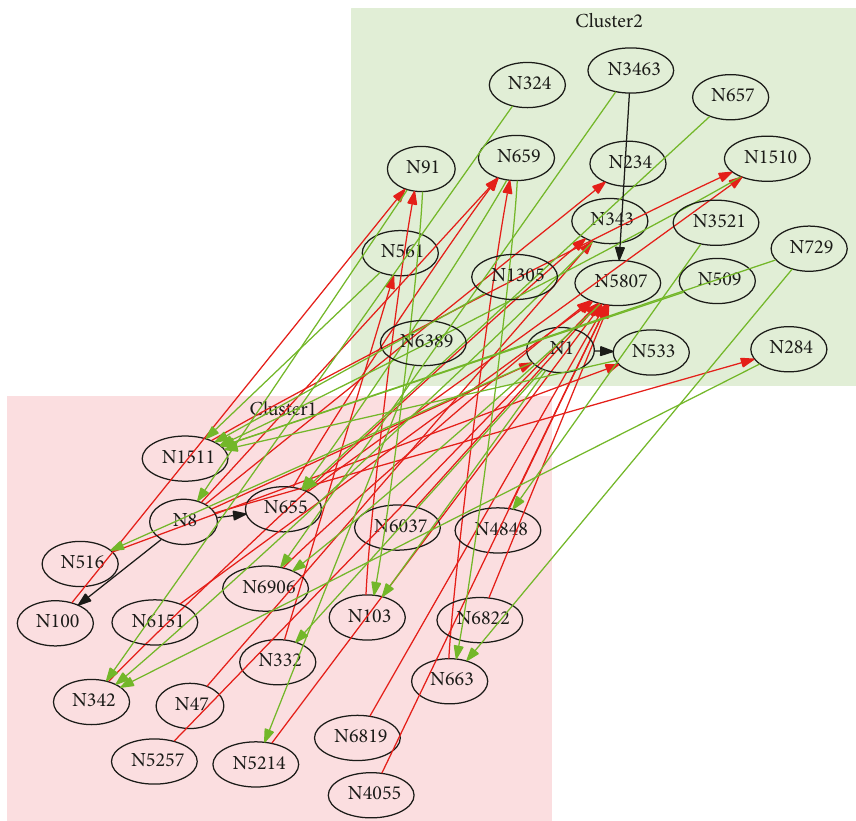
Figure 15: Clustering for Wikipedia who-votes-on-whom network with 2.9% of initial number of nodes in both cluster C1 and cluster C2. Nodes labels are nodes numbers in the network before removing sources. The nodes from cluster C1 are situated on light red background. The nodes from clusterC2 are situated on light green background. The edges going from clusterC1 to clusterC2 are red, the edges going from cluster C2 to cluster C1 are green, and the edges inside clusters are black.